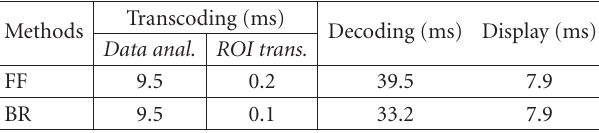
Table 3: Processing time (Mobile Pentium 1.6GHz, 1GB memory,